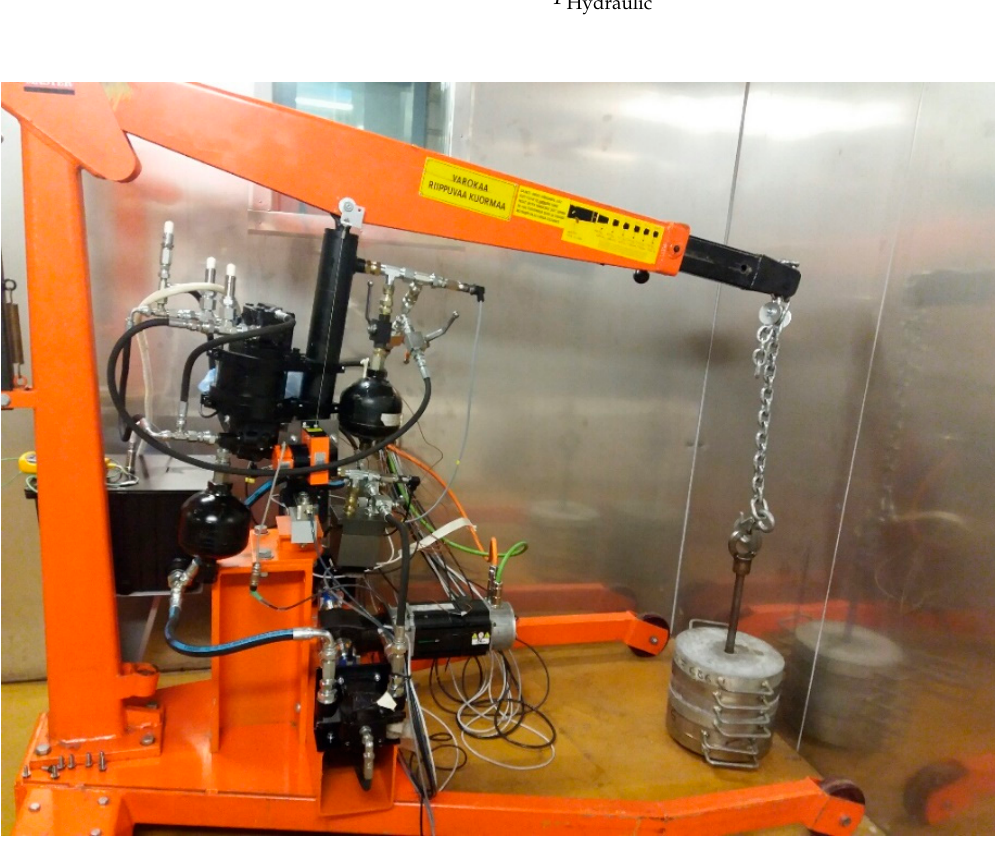
Figure 2. Photo of the direct driven hydraulic (DDH) setup in the cold chamber.